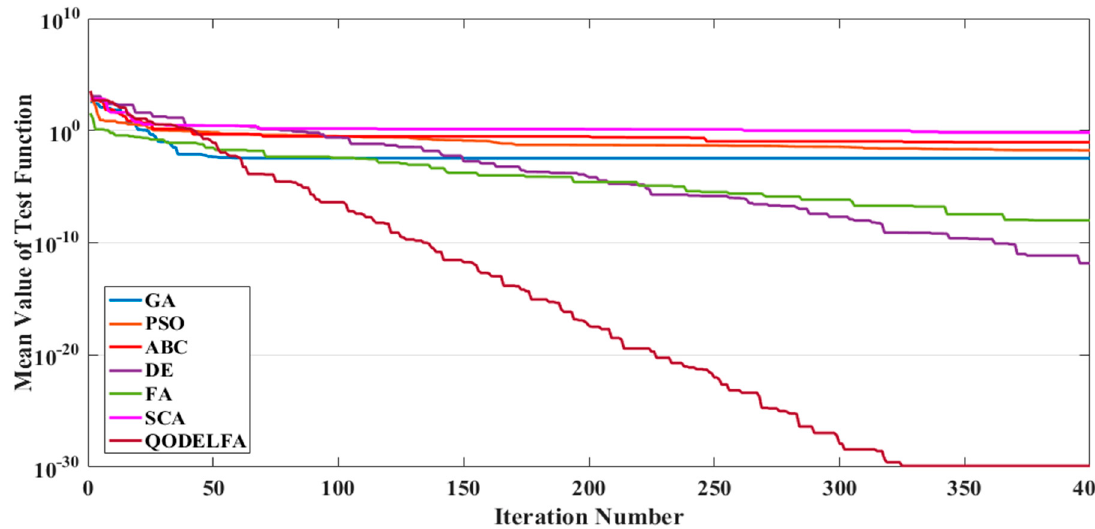
Appl. Sci. 2019 , 9 , x FOR PEER REVIEW Figure 5. Convergence characteristics for the Rosenbrock function. Figure 5. Convergence characteristics for the Rosenbrock function. Figure 5. Convergence characteristics for the Rosenbrock function.